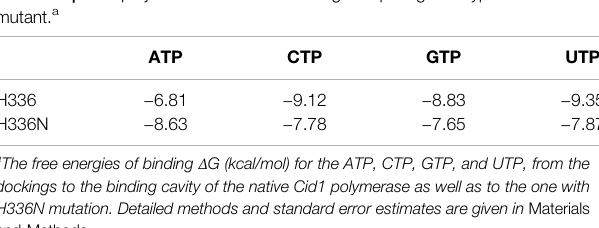
Table S1 ) and different oligonucleotides for each application ( Supplementary Table S2 ). All experiments on read-in and read-